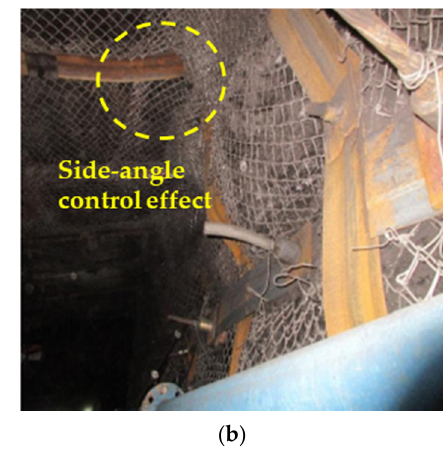
Figure 21. Monitoring of roadway deformation and its speed. ( a ) Deformation of roof and floor of the roadway; ( b ) deformation of the coal sides of the roadway.